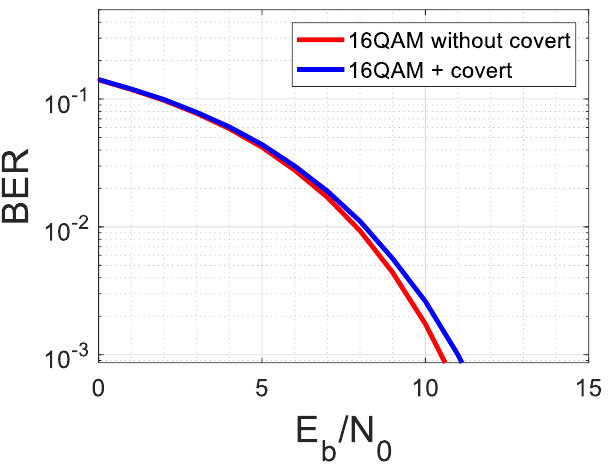
Figure 6. Comparison on BERs for 16QAM and 16QAM disturbed by covert signal in AWGN chan- nel.